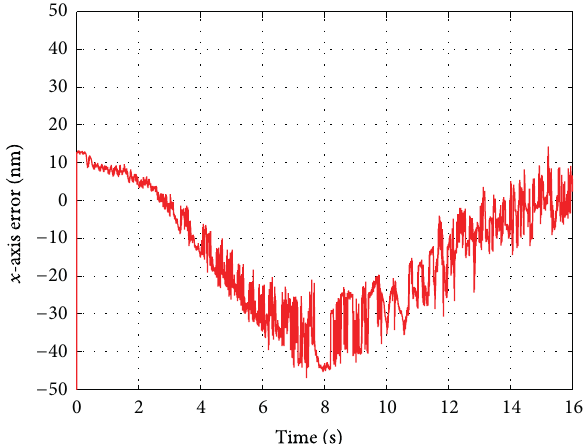
Figure 12: Error generated by computational model in 𝑋